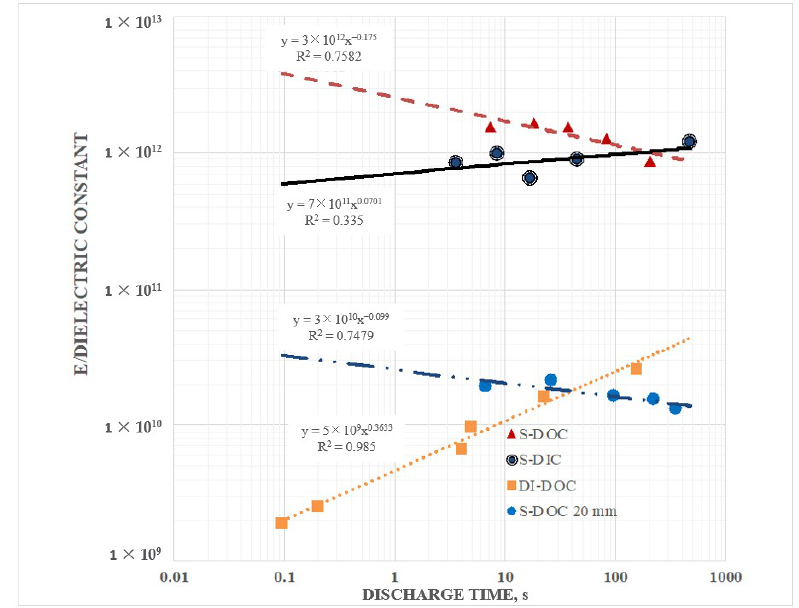
Figure 5. Values for a 6 mm capacitor—Shown are the effective dielectric values below 1 V for the S-DOC and DI-DOC configurations (0.5% NaCl, 10 V charge, 200 s hold) for the 6 mm capacitor. Shown, for comparison, is also the S-DOC for the 20 mm capacitor, same operating parameters. It is notable that the power law fits were imperfect, indicating that extrapolation of the curves was not necessarily valid.